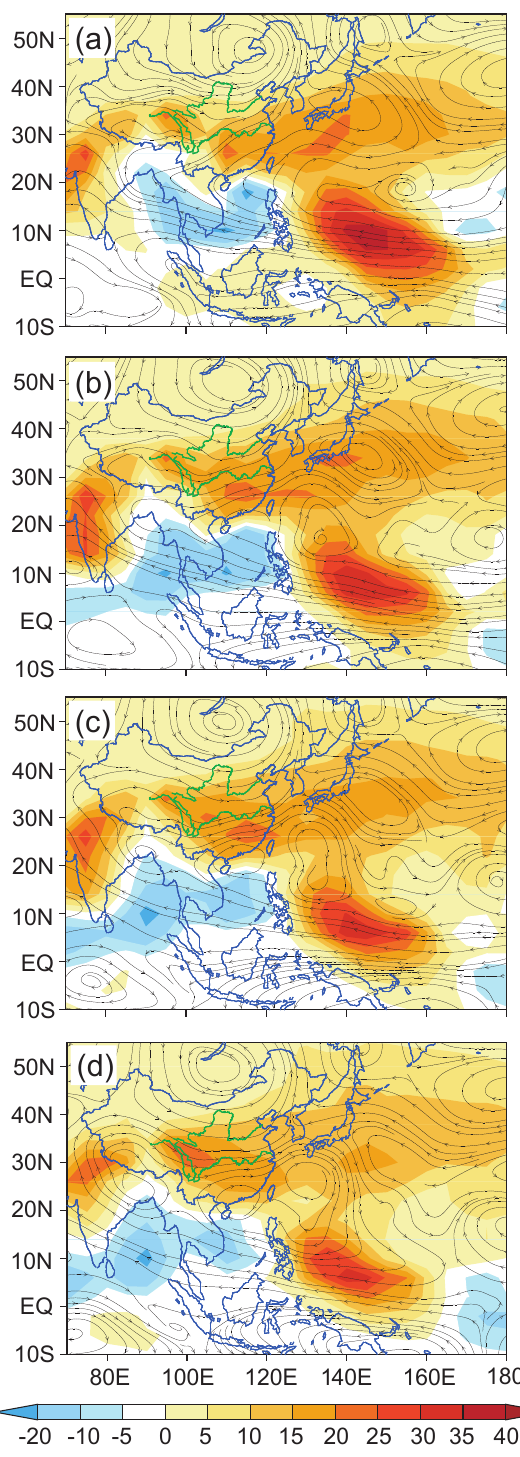
Fig. 6. The differences in summer (JJAS) mean RatiosOC (color shades) and wind stream between 1998 and 2002 (the former minus latter) at (a) 850hPa; (b) 700hPa; (c) 600hPa; (d) 500hPa. Meteo- rological fields are from the GEOS-4 assimilated